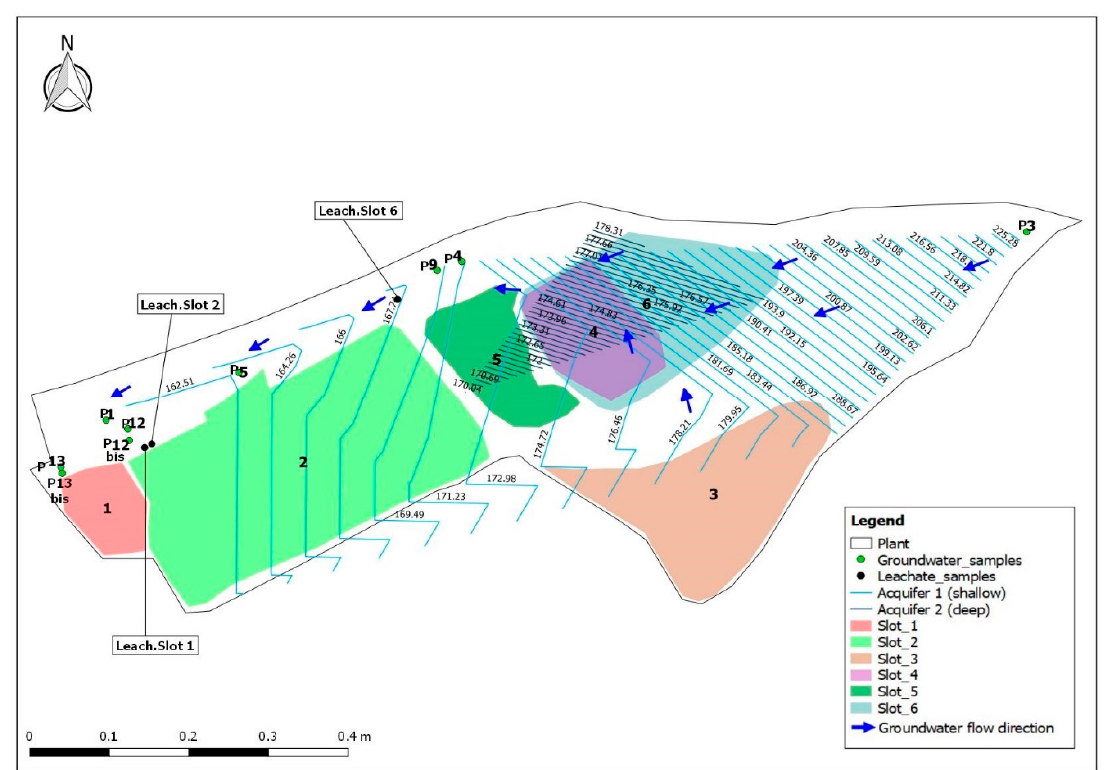
Figure 2. Water table map of Case History I.